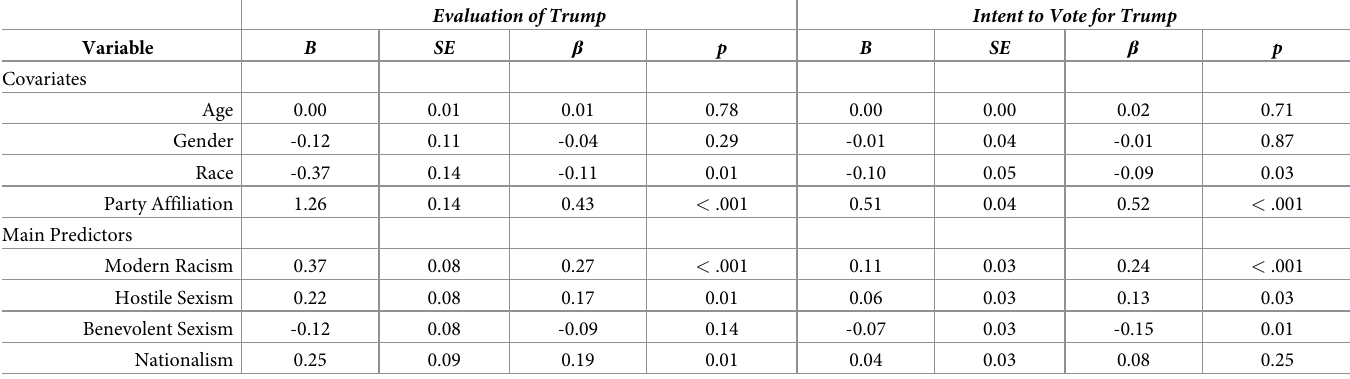
Table 4. Standardized estimates, unstandardized estimates, and standard errors for structural model predicting evaluation of Trump and intent to vote for Trump at Time 1.